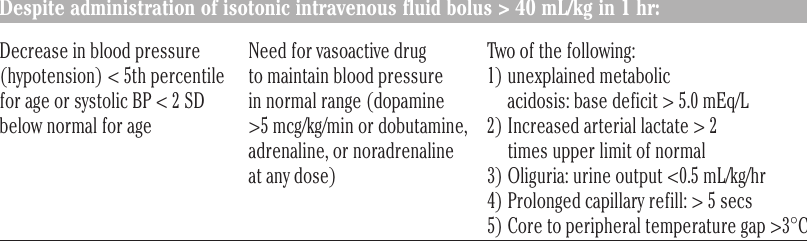
Table 1. Cardiovascular dysfunction criteria (modified from Goldstein et al . 7 ). Despite administration of isotonic intravenous fluid bolus > 40 mL/kg in 1 hr: